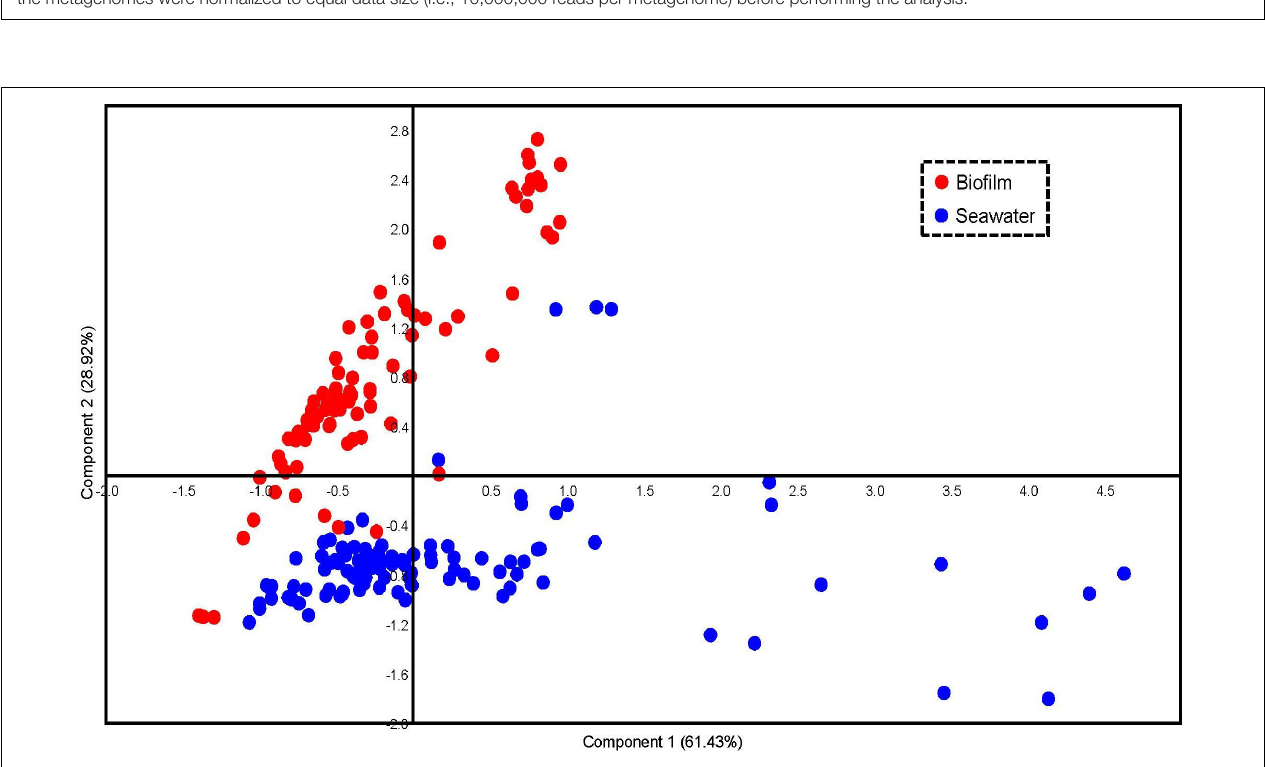
FIGURE 2 | Principal coordinates analysis (PCoA) of regulation and signal transduction subsystems in biofilm and seawater microbial communities. In total, 101 normalized biofilm metagenomes and 91 normalized seawater metagenomes were included in this analysis. Bray–Curtis distances were calculated based on the type and relative abundance of regulation and signal transduction subsystems and visualized in the PCoA plot.